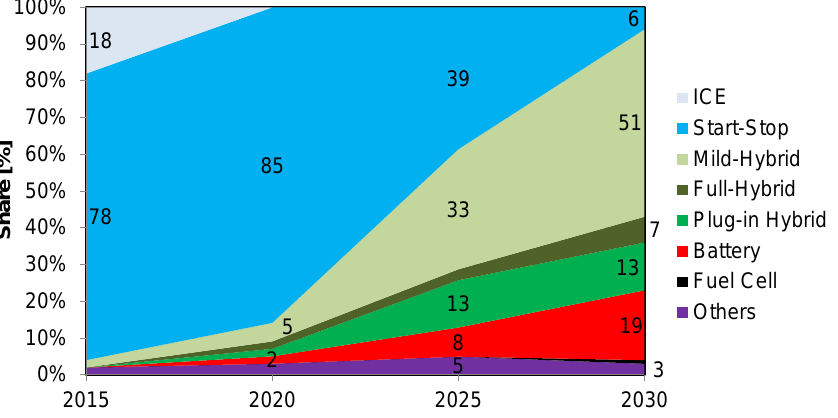
Figure 1. Prediction of change in share of powertrains used in vehicles by 2030 [8]; CO 2 fleet emissions: 95 g/km (2020), 75 g/km (2025), and 65 g/km (2030).